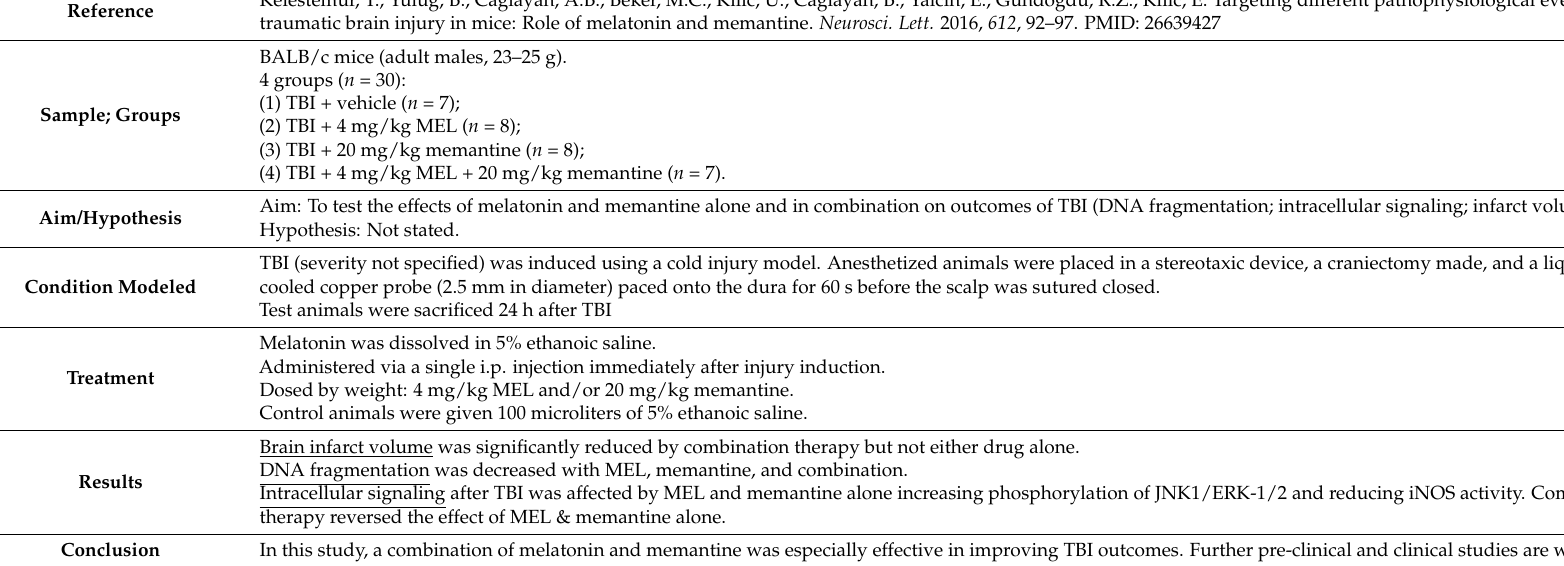
Table A19. Kelestemur et al. (2016) Study